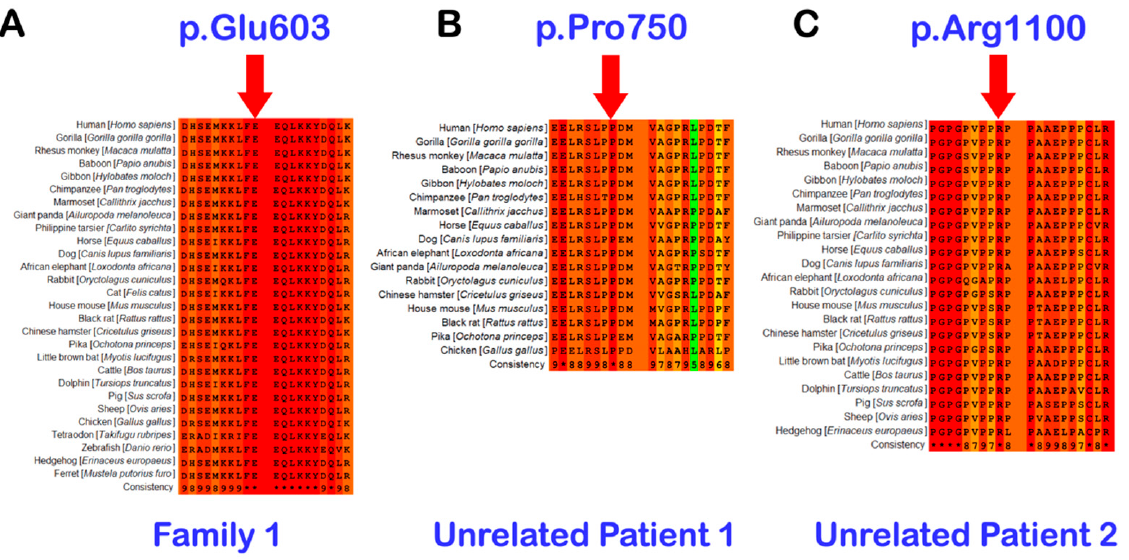
Figure 4. Conservation of amino acid residues ( A ) p.Glu603, ( B ) p.Pro750, and ( C ) p.Arg1100 across vertebrate species. All amino acids are highly conserved.